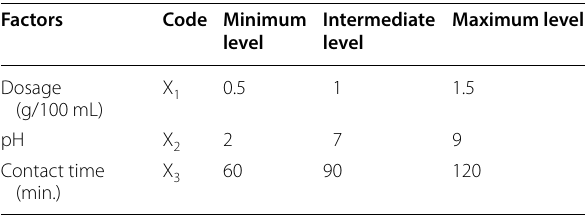
Table 1 Factors and their levels for removal of